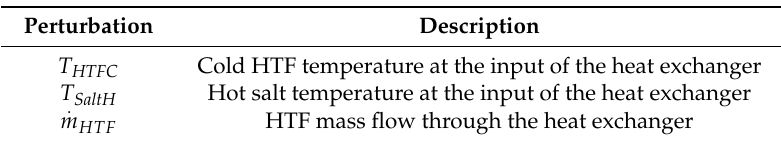
Table 2. TES Discharging Input Perturbations.